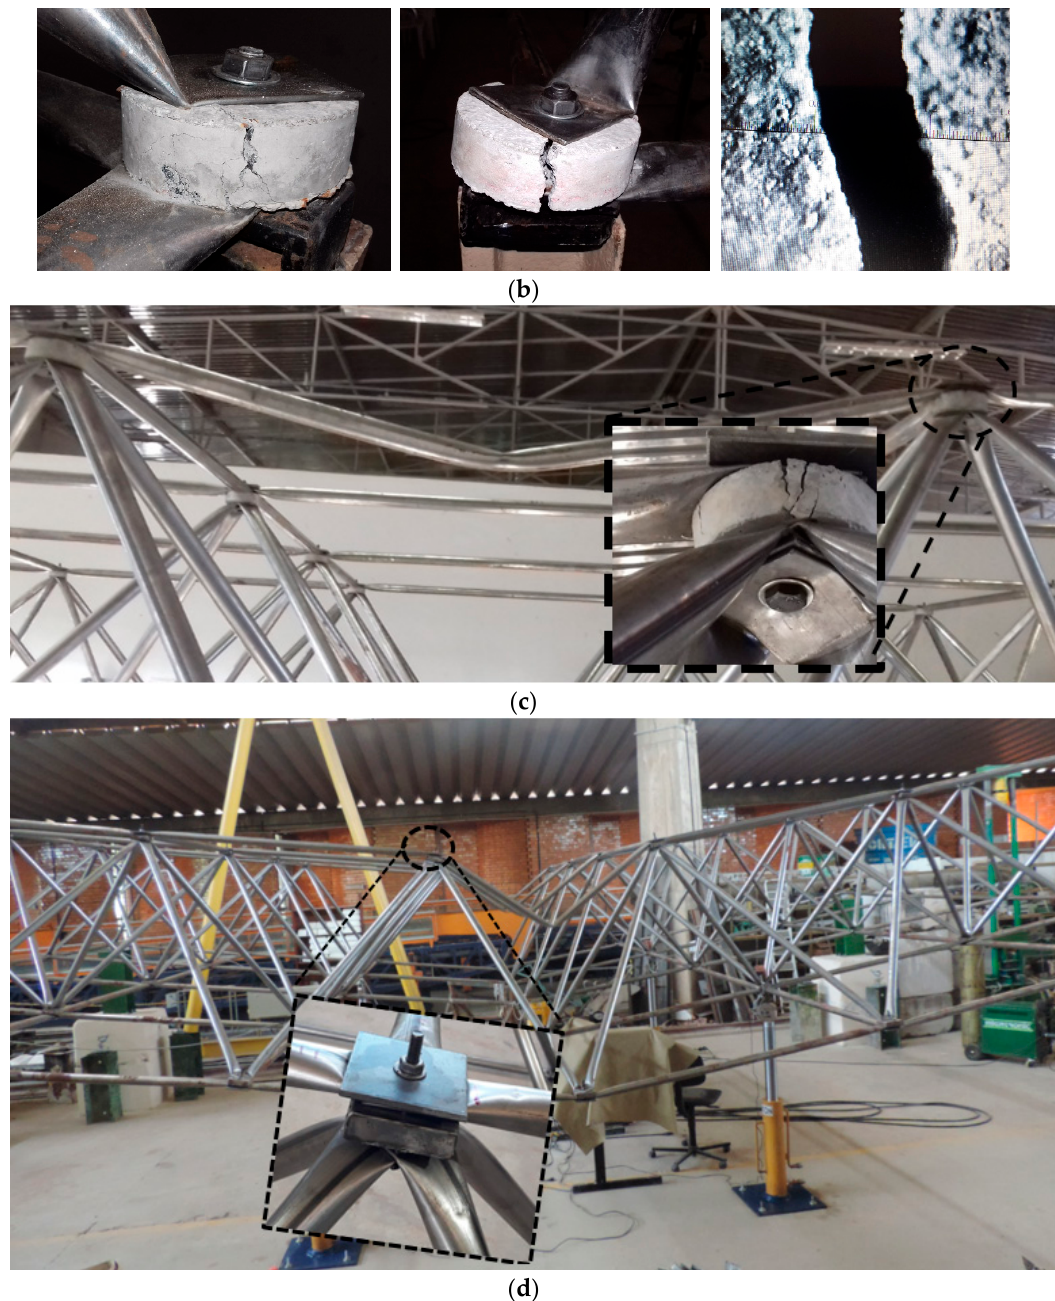
Figure 19. Details of the space truss collapse modes. ( a ) Collapse of typical connection caused by bending moment due to eccentricities, ( b , c ) failure of the concrete spacer, ( d ) concrete encapsulated with steel fiber.